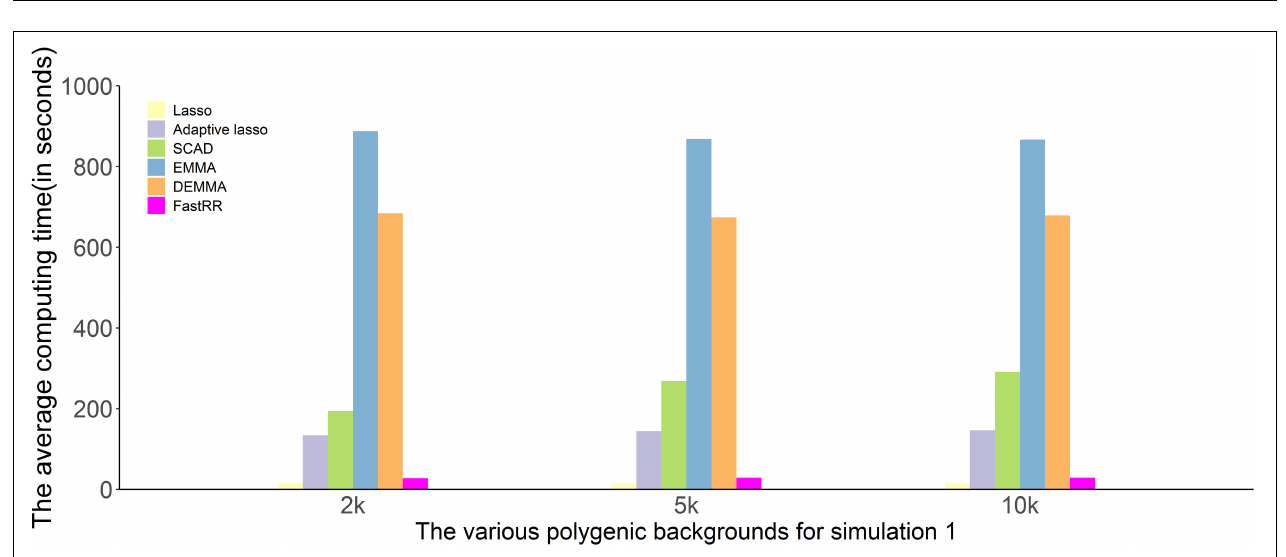
FIGURE 4 | Comparison of computing times to analyze simulation experiment 1 using all six methods (lasso, adaptive lasso, SCAD, EMMA, DEMMA, and the FastRR